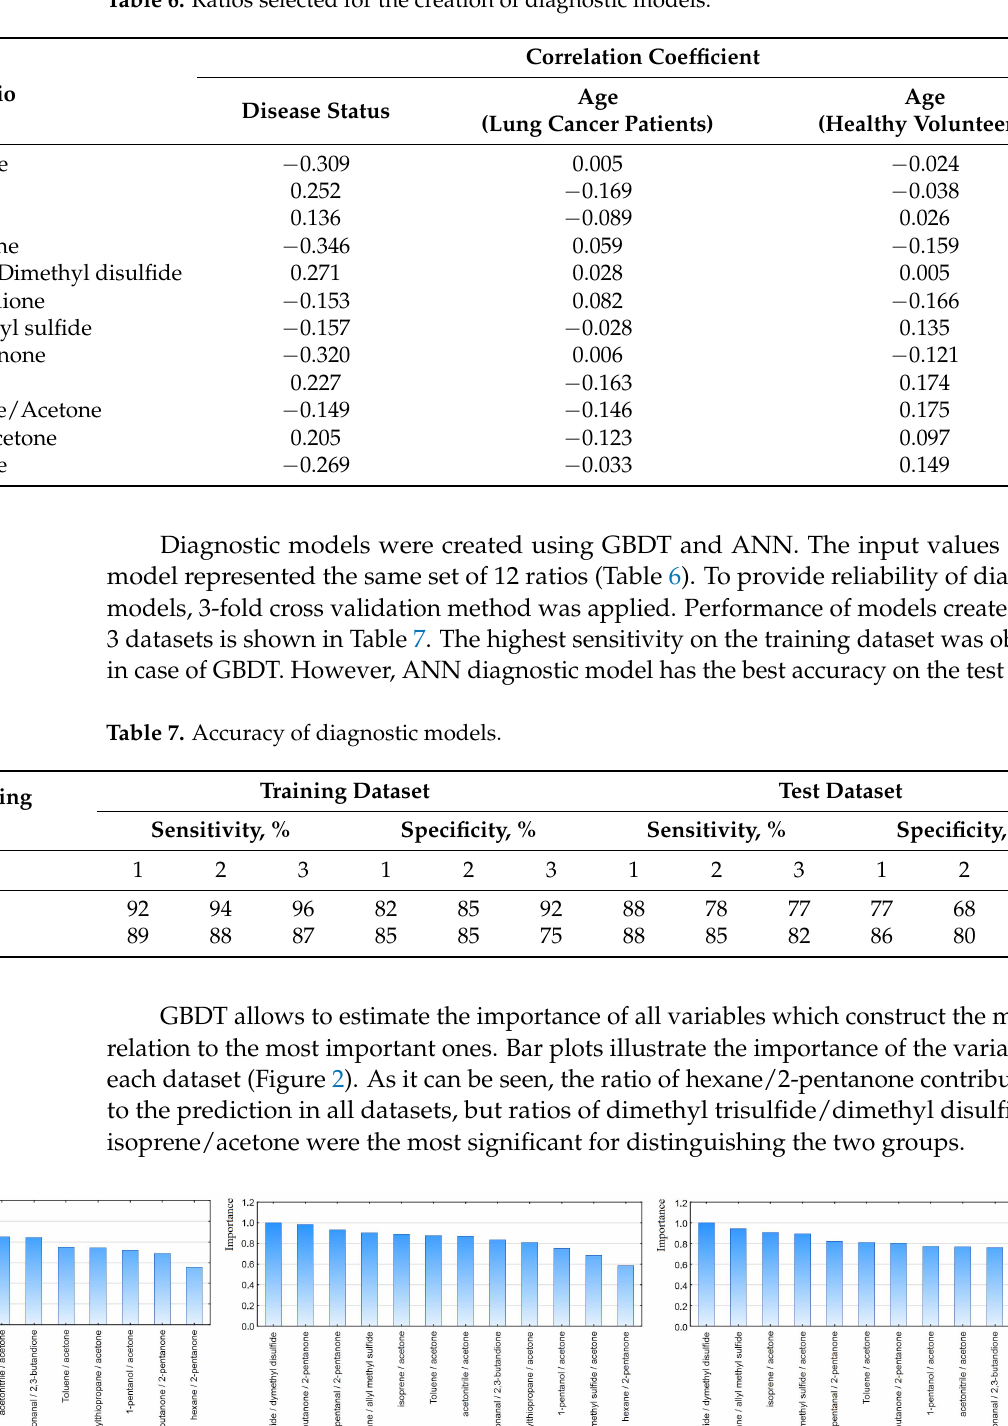
Table 6. Ratios selected for the creation of diagnostic models.